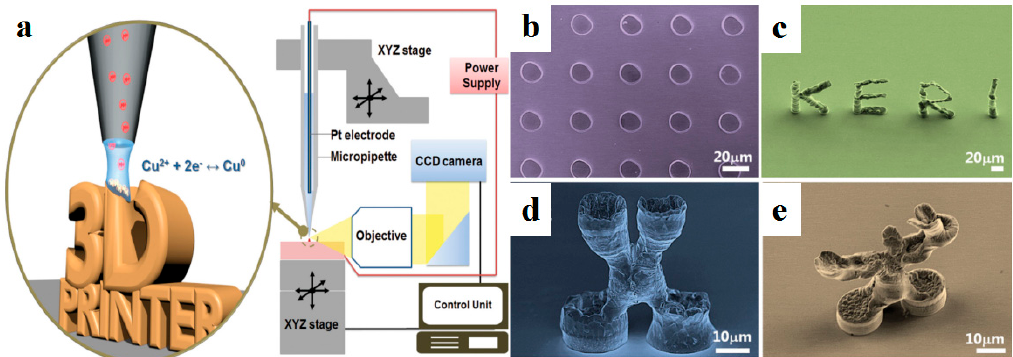
Figure 3. Electrodeposition-based 3D printing of Cu microarchitectures with in situ reactive inks. ( a ) Schematic illustration of electrodeposition-based 3D printing of in situ reactive Cu ions; ( b – e ) 3D-printed Cu architectures with different shapes, reprinted from [34] with the permission of John Wiley and Sons, Copyright 2015.